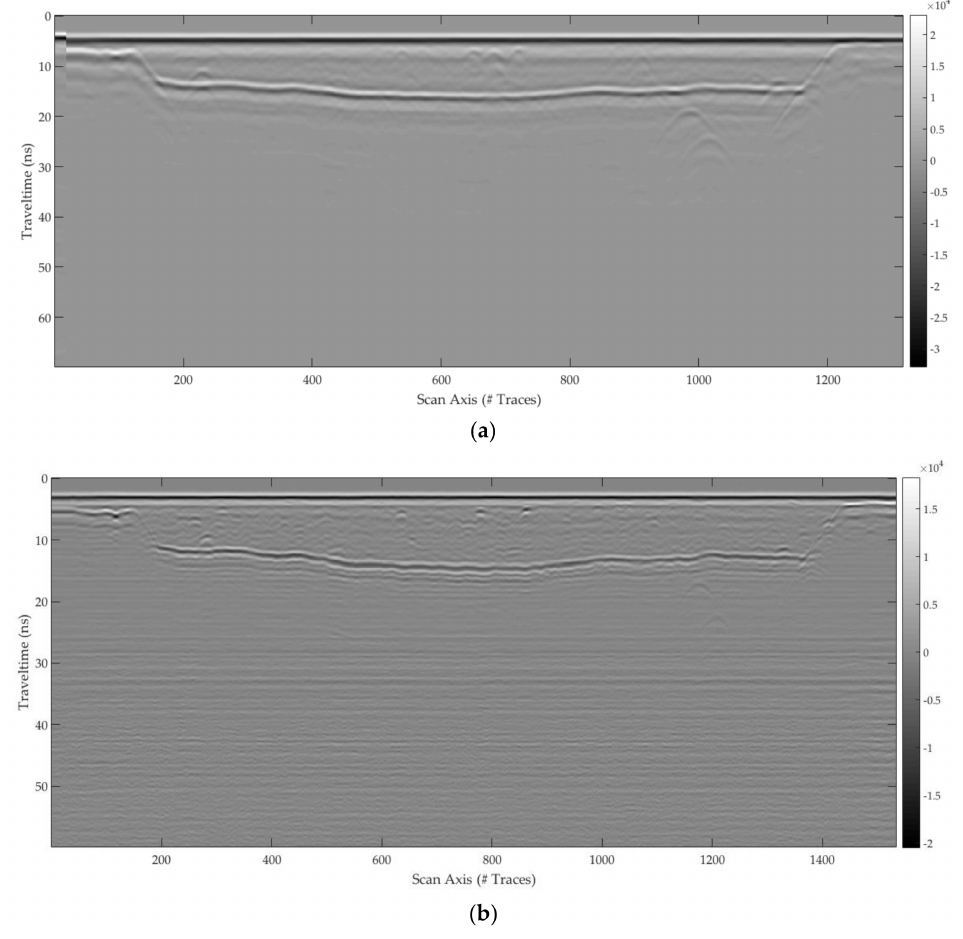
Figure 19. Profiles recorded in the silt region by using GPR 1, on acquisition line 2, with antennas operating at: ( a ) 400 MHz; ( b ) 900 MHz. Data recorded at 200 MHz are in Figure 15.